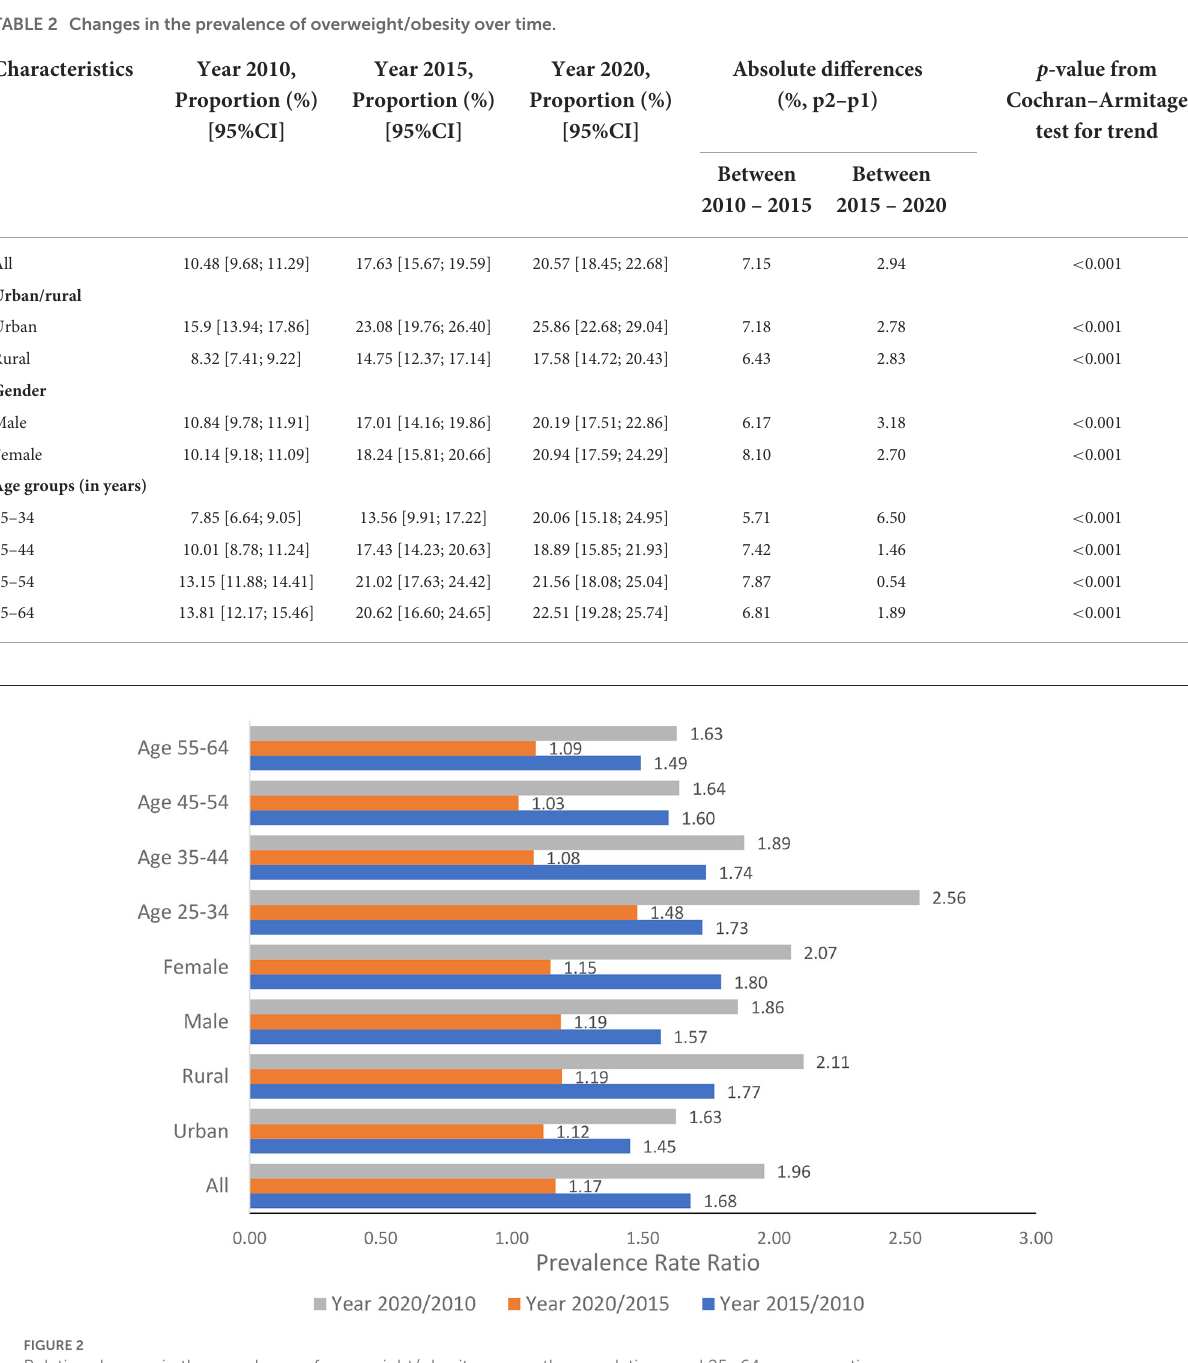
Table 2 examines the changes in the prevalence of overweight/obesity over the last 10 years. The overall